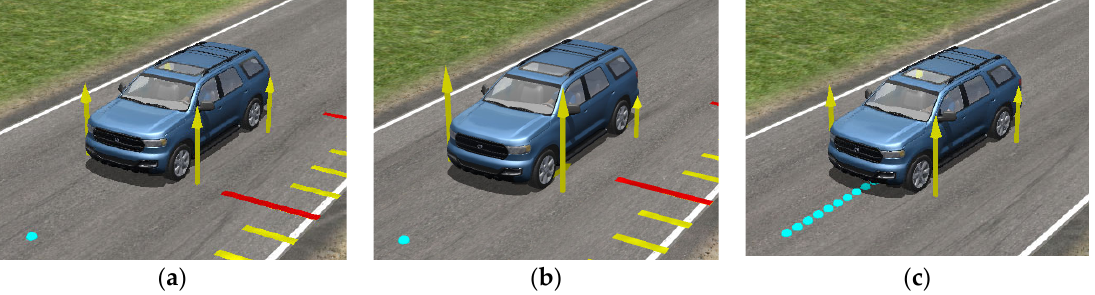
Figure 11. Emergency brake simulation scene on a straight road: ( a ) constant speed; ( b ) emergency brake; ( c ) stopped.